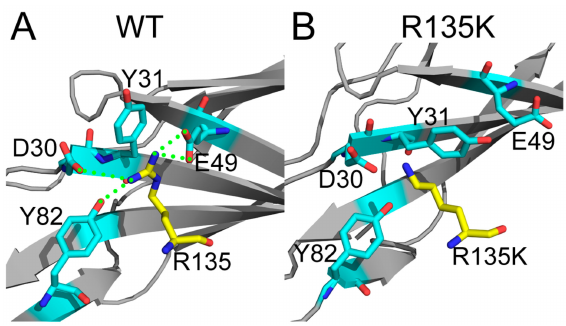
Figure 5. Detailed interaction around mutation site in wild type system ( A ); and R135K system ( B ). R135(K) in H-Ras was in yellow, and important residues in NS1 interacting with R135 were in cyan. Inter-molecular hydrogen bonds were depicted by green dashed lines, and the overall structures of NS1 were in gray. For clarity, non-polar hydrogen atoms were